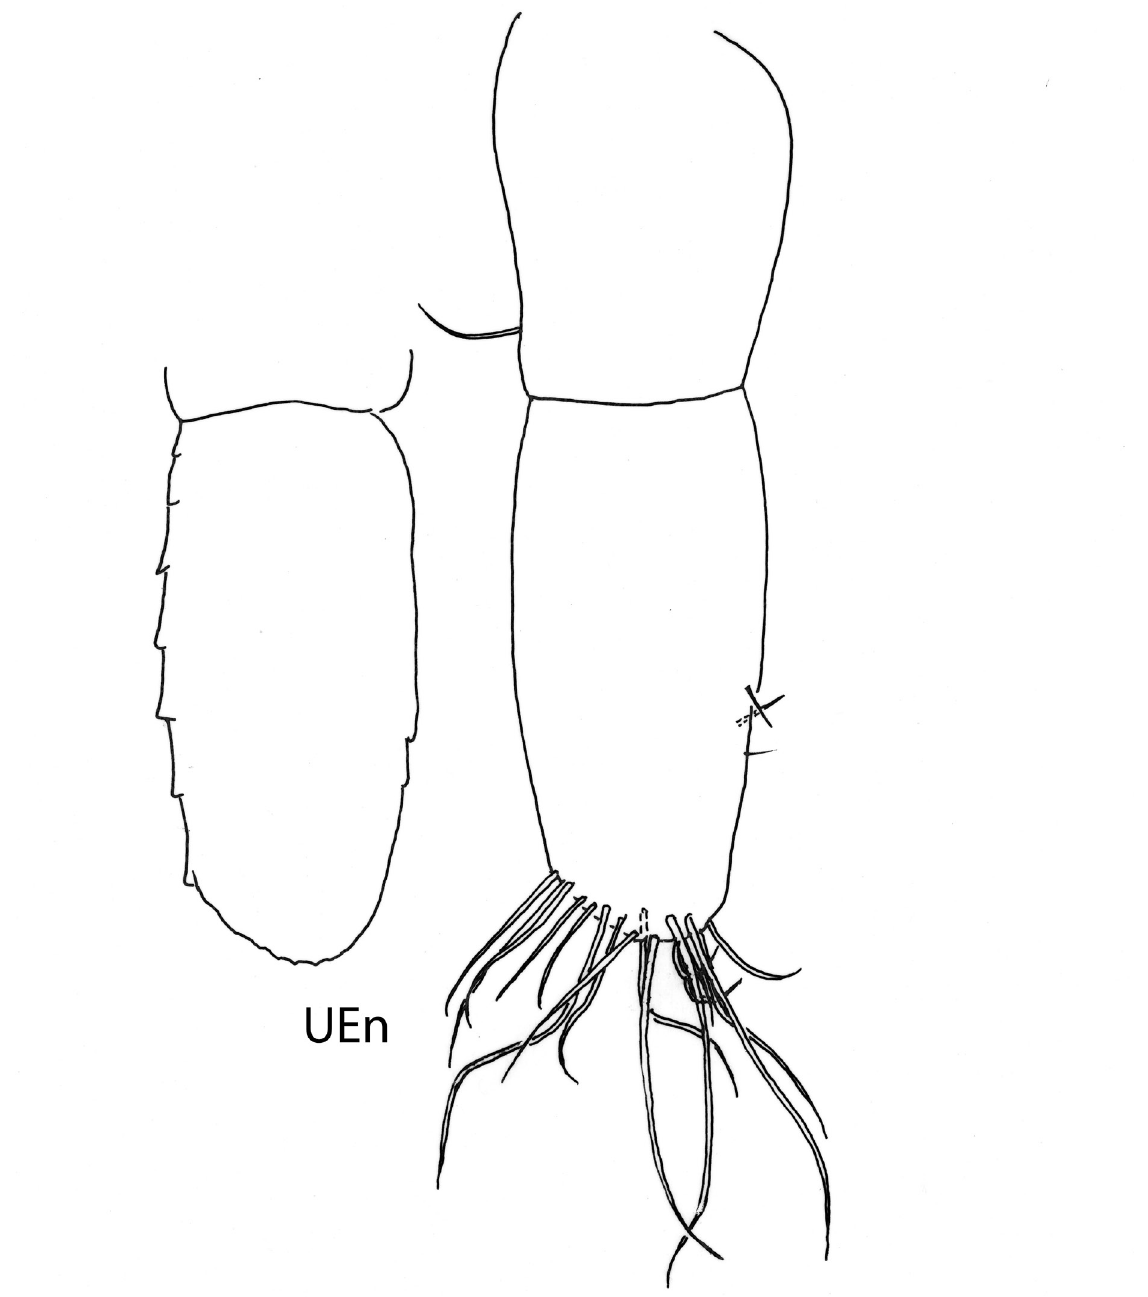
Fig. 13. Kupellonura macaroni sp. nov., holotype, immature adult (MZB Iso 102). Abbreviation: Uen = endopod of uropod, two views (setae omitted in left drawing). Serrations can be difficult to see at certain view